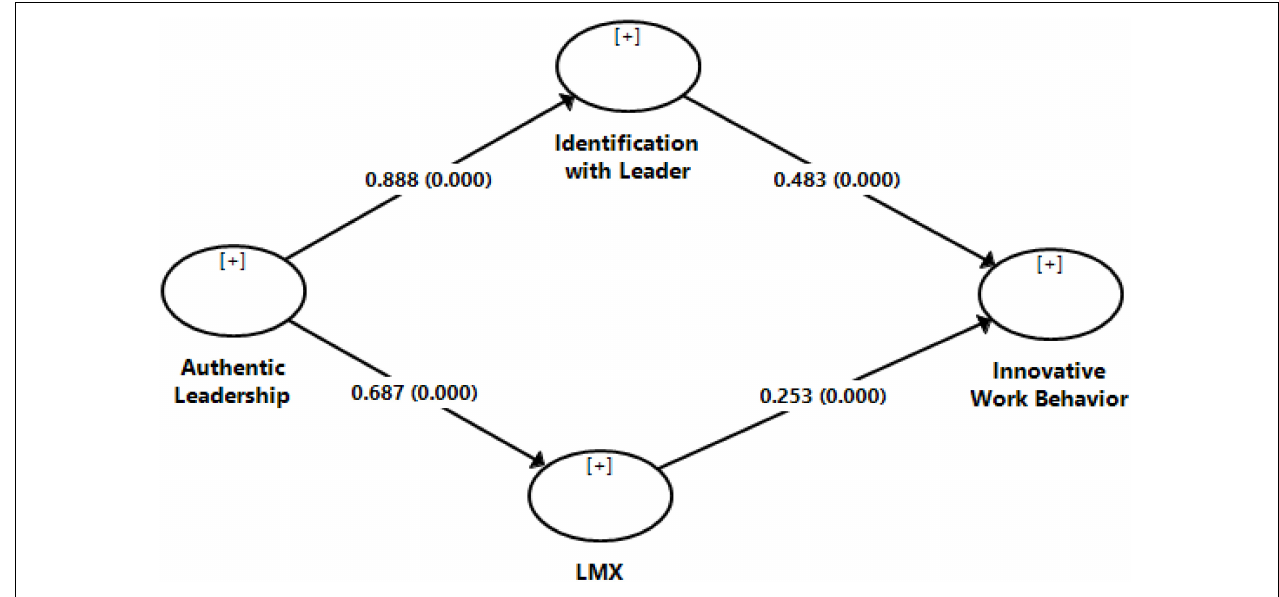
FIGURE 2 | An estimated structural